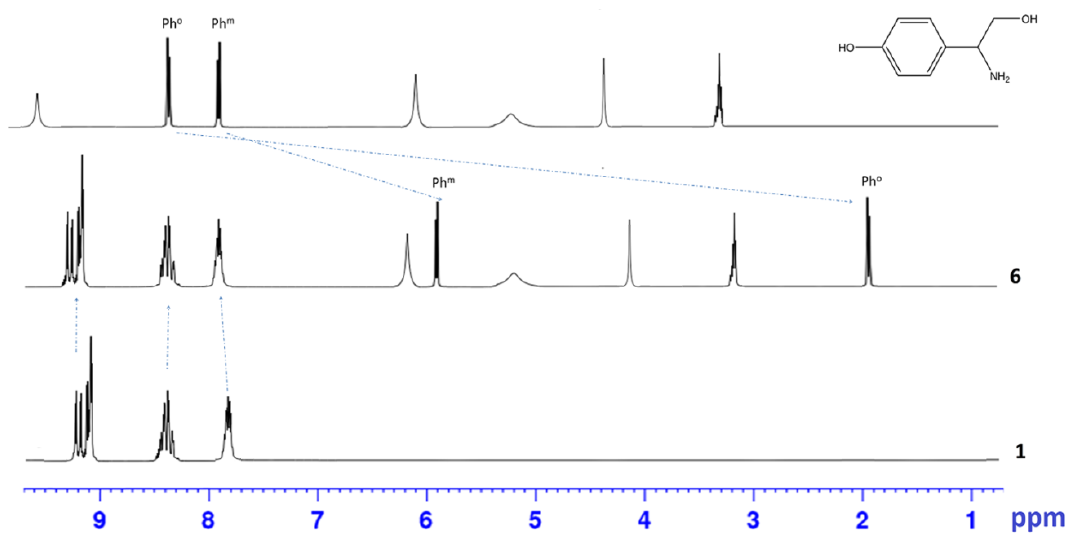
Figure 1. 1 Н NMR− spectrum of the Sn(OH) 2 P 1 , Sn(L) 2 P 6, and octopamine in DMSO − d 6 . Figure 1. 1 Н NMR-spectrum of the Sn(OH)